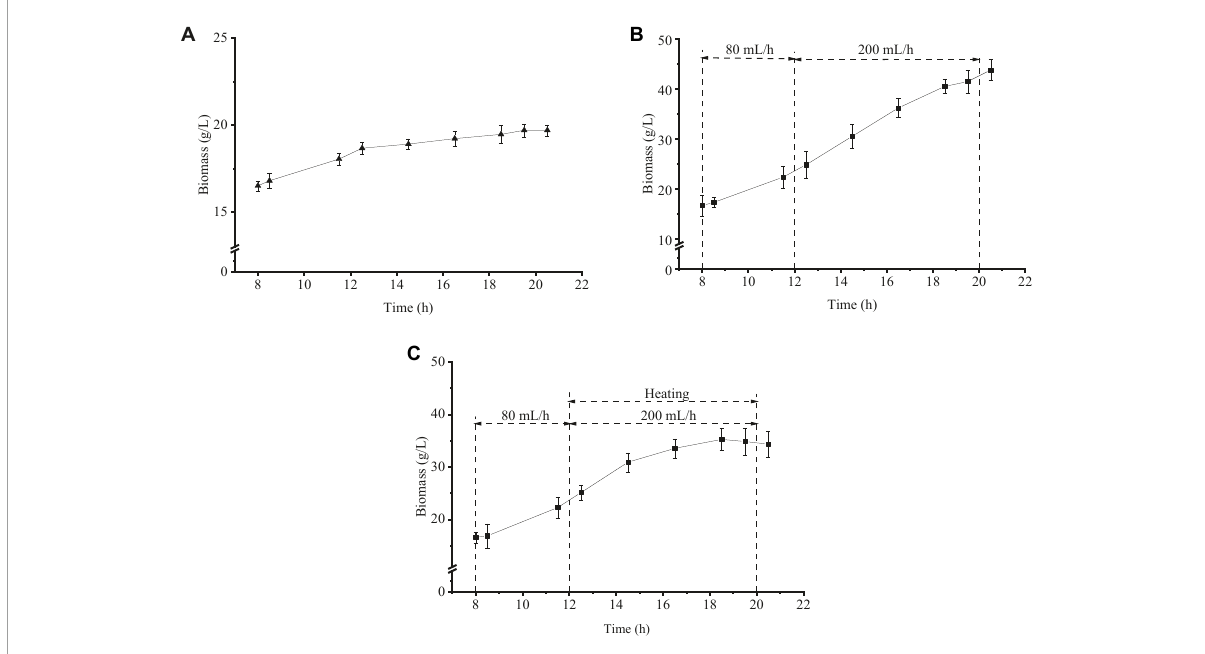
FIGURE1 Growth differences of Z. rouxii using three fermentation regulation strategies. (A) Unregulated, (B) strategy 1, (C) strategy